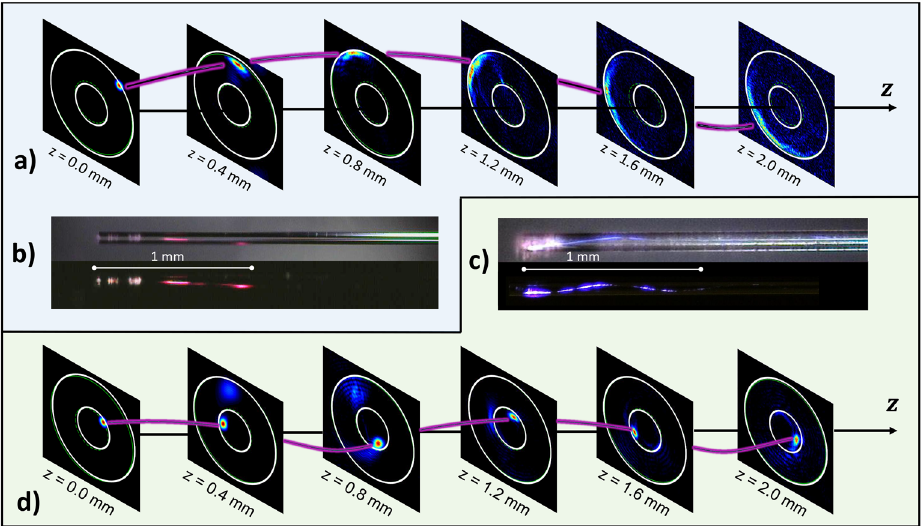
Figure 3. TOAM carrying beam tracking, obtained when the input beam is incident at the cladding–air ( a , b ) or the core–cladding interface ( c , d ), respectively. The purple curves in ( a ) and ( d ) represent the Poynting vector trajectory. Simulated near-field intensities are compared with experimentally observed luminescence intensities.